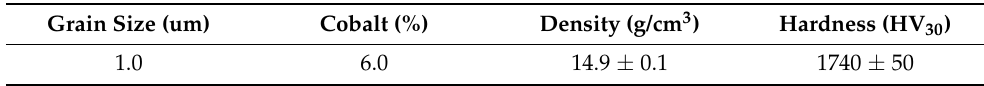
Table 3. Characteristics of WC-Co raw material (Grade: GK05A).